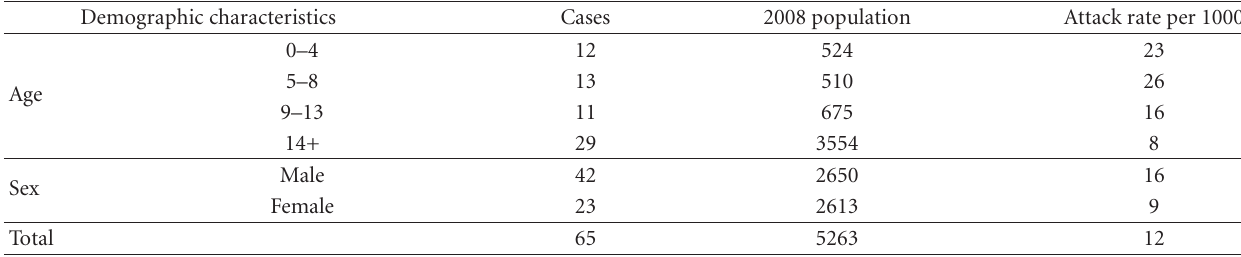
Table 1: Incidence of organophosphorous poisoning by age and sex, Sindhikela, Bolangir, Orissa, India, 2008. Demographic characteristics